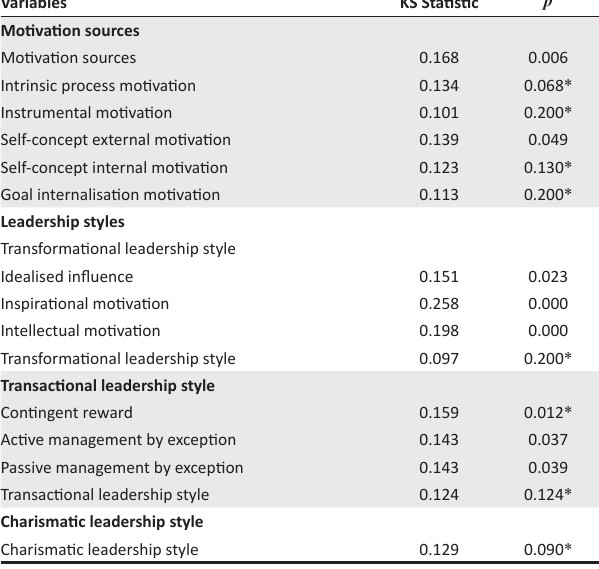
TABLE 2: Test for normality results.